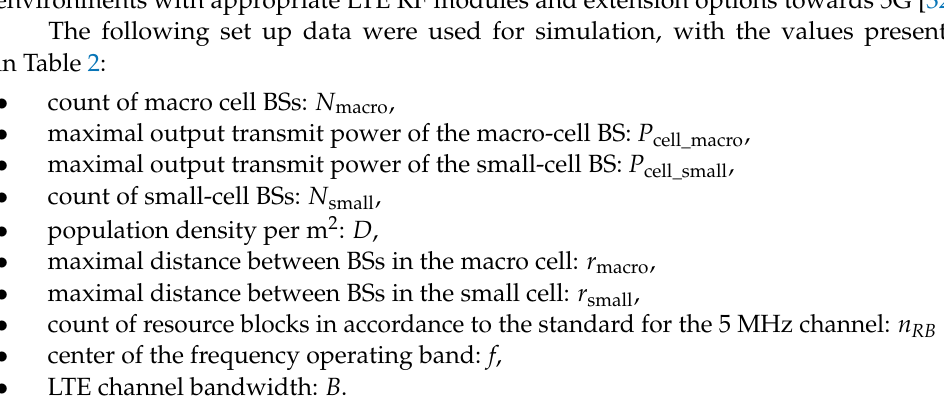
Table 2. Network parameters used in ns-3 simulation. Parameter